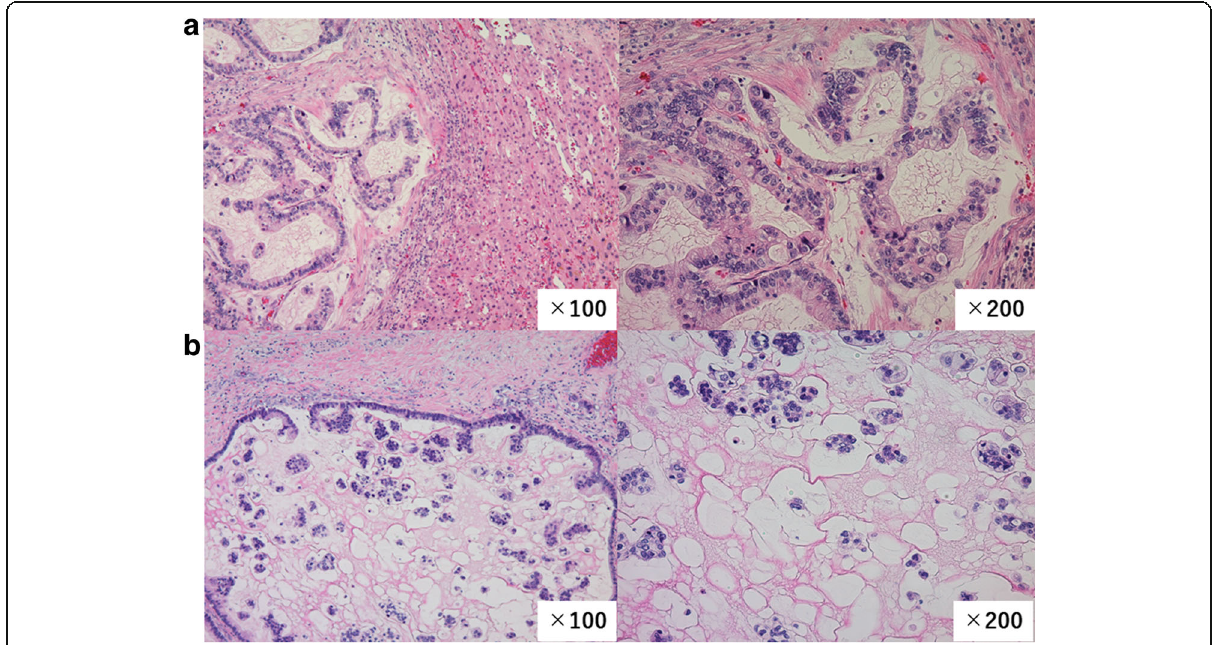
Fig. 3 a Columnar tumor cells with abundant cytoplasmic mucus arranged in papillary or tubular structure (HE staining). Original magnification: × 200 (right) and × 100 (left). b Abundant mucus at extracellular region; tumor cells observed in mucus lakes (HE staining). Original magnification: × 200 (right) and × 100